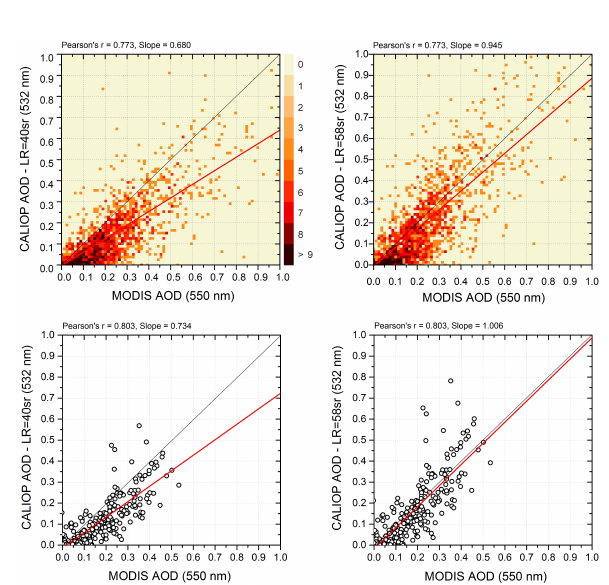
Fig. 3. Comparison of CALIPSO AODs (1 ◦ × 1 ◦ ) vs. collocated MODIS-Aqua Level 3 using LR equal to 40sr (left) and LR equal to 58sr (right). Upper: 2-D histograms representing the number of cases found for each CALIPSO–MODIS AOD bin between 0 and 1.0 (bin step equal to 0.0125). MODIS data are not filtered, while CALPISO data are filtered according to Level 3 specifications. Only CALIPSO overpasses that are cloud-free and for which the aerosol classification scheme reveals only dust presence are considered. Lower: data are screened to ensure horizontal homogeneity in the cell and CALPISO data representativeness comparing to MODIS spatial averages, as well as cloud-free conditions for the MODIS